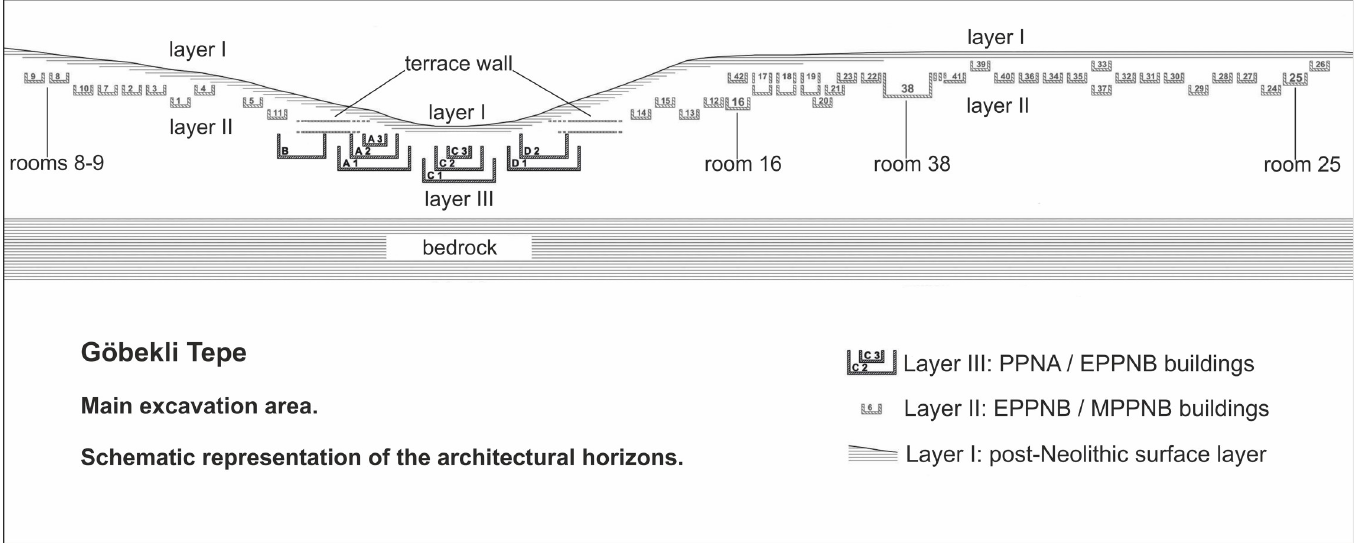
Fig 2. Stratigraphy of Go¨bekli Tepe. Schematic representation of the architectural horizons in the main excavation area (modified after a plan by D. Kurapkat [56]).